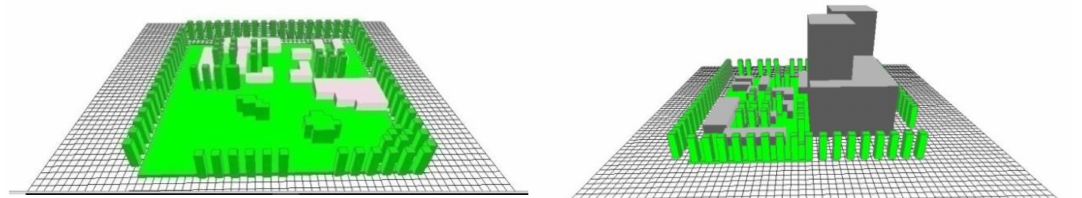
Figure 6. 2006 3D morphology (left) and 2013 3D morphology (right) in